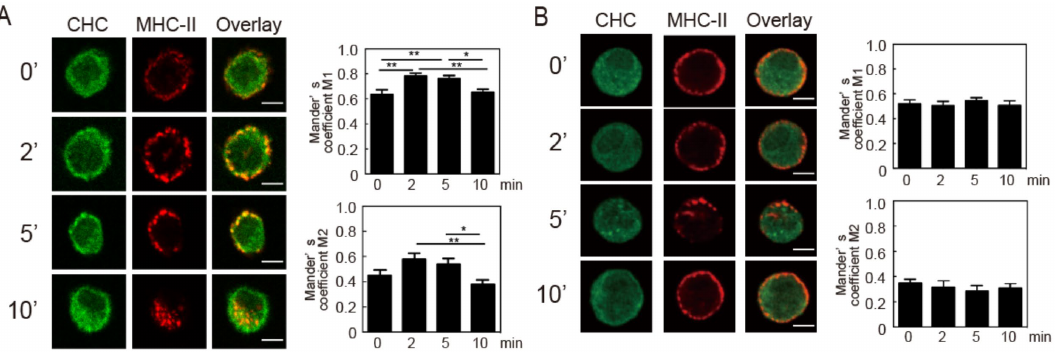
Figure 7. Crosslinking-induced endocytosis of MHC-II is clathrin-dependent. ( A ) BMDCs were incubated with an anti-MHC-II antibody for 30 min at 4 °C. ( B ) BMDCs pre-incubated with chlorpromazine (30 µM) for 30 min at 37 °C were incubated with an anti-MHC-II antibody for 30 min at 4 °C. The cells were washed and crosslinked with an Alexa 546-labeled anti-mouse IgG for the indicated time periods at 37 °C. The cells were fixed, permeabilized, and stained with an anti-clathrin heavy chain (CHC) antibody and an Alexa Fluor 488-labeled secondary antibody. bars = 2µm. Co-localization of MHC-II and CHC was quantified by calculating Manders’ coefficients M1 (green pixels (CHC) overlapping red pixels (MHC-II)) and M2 (red pixels overlapping green pixels) using ImageJ software. Values are presented as the mean ± SEM (n = 10), * p < 0.05, ** p < 0.01.